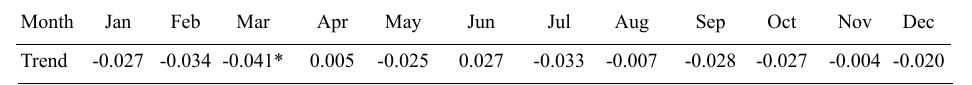
Trends of monthly diurnal temperature range (°C p.a.) for the period 1960 to 2001 (* indicates significance at the 5 %